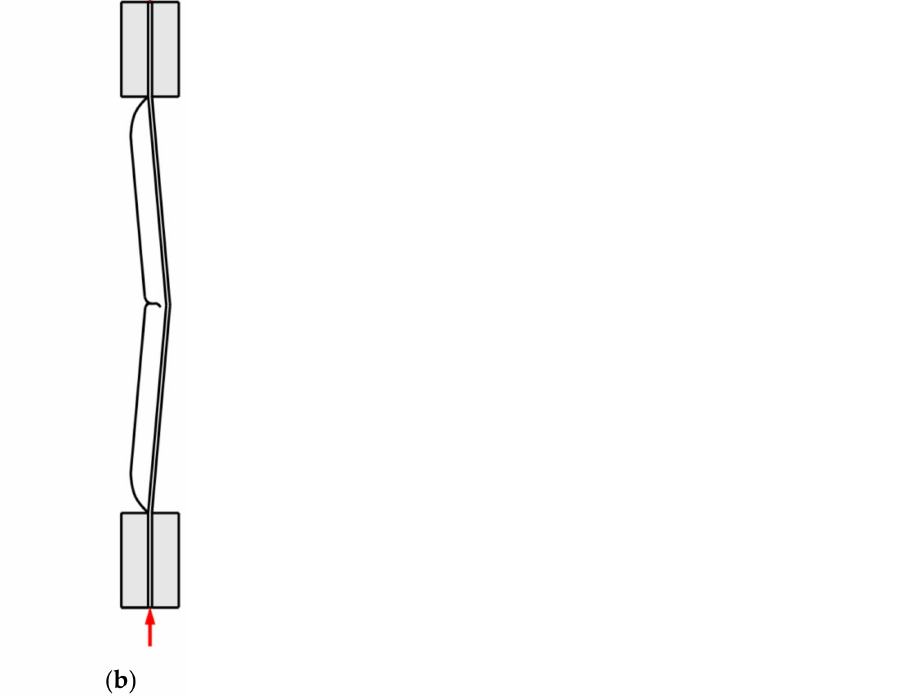
the axial compression test.